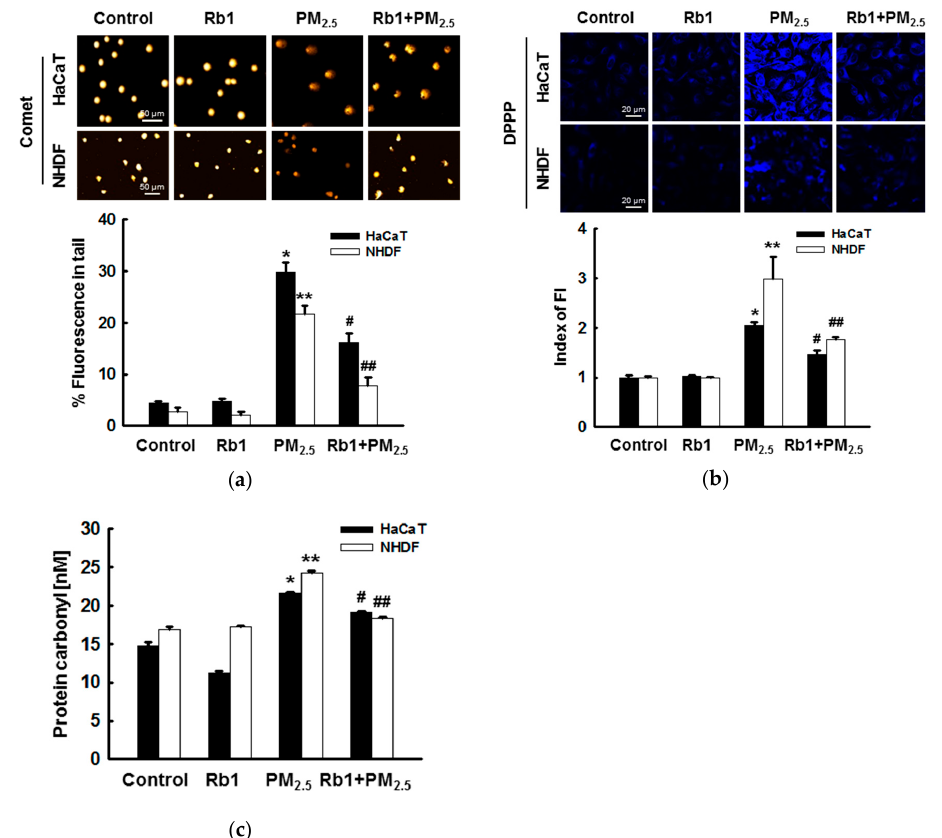
Figure 3. Ginsenoside Rb1 confers protection from PM 2.5 -induced oxidative stress. ( a ) DNA damage was evaluated by the comet assay; representative images show comet tails, and the graph shows the quantification of cellular DNA damage. ( b ) Lipid peroxidation was analyzed by confocal microscopy after DPPP staining. ( c ) Protein oxidation was assayed by measuring carbonyl formation. ( a – c ) *,** p < 0.05 compared to the control groups of both HaCaT and NHDF cells, respectively; # , ## p < 0.05 compared to PM 2.5 -treated groups of both HaCaT and NHDF cells,